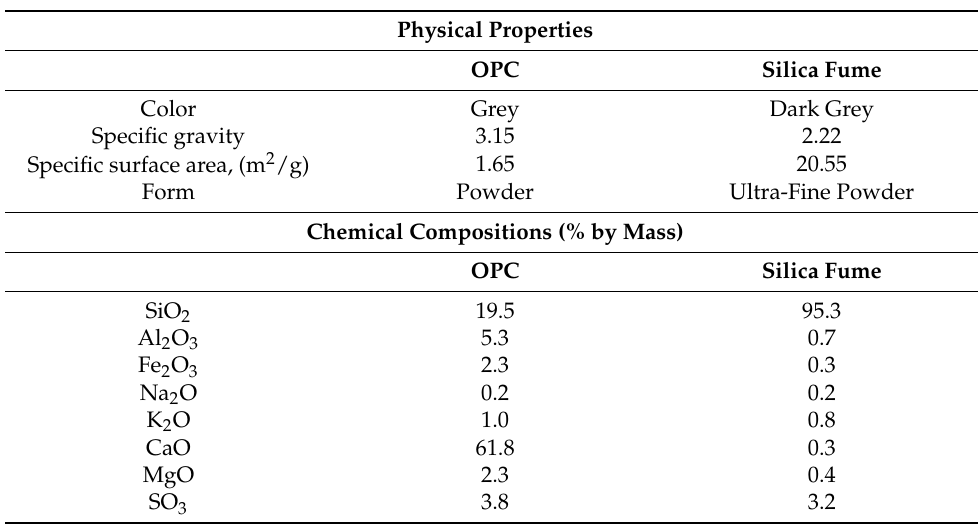
Figure 3. Compressive strength testing of polystyrene capsule.